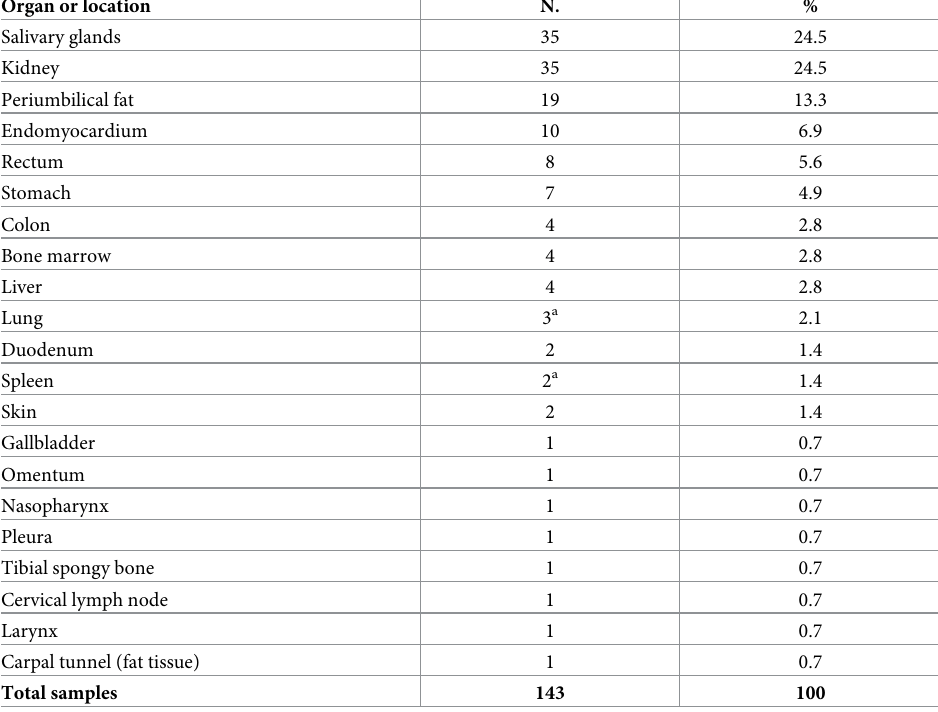
a Two splenic and one pulmonary samples corresponded to surgical specimens.